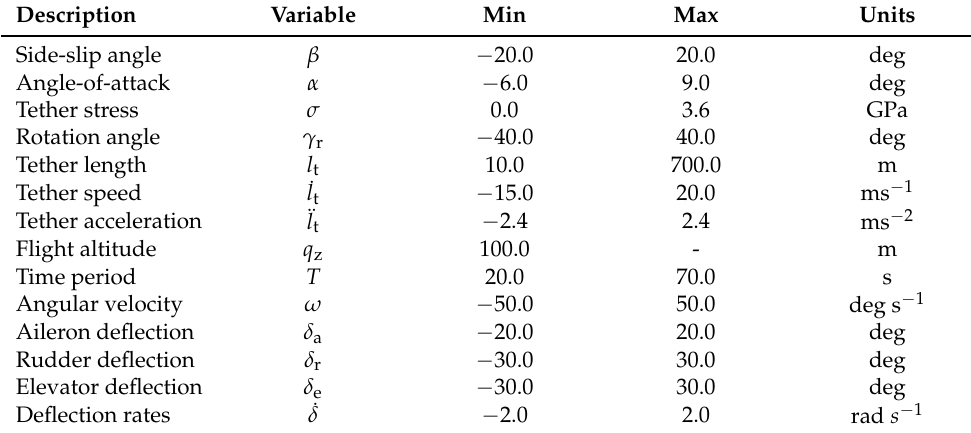
Table 2. System variable bounds and path